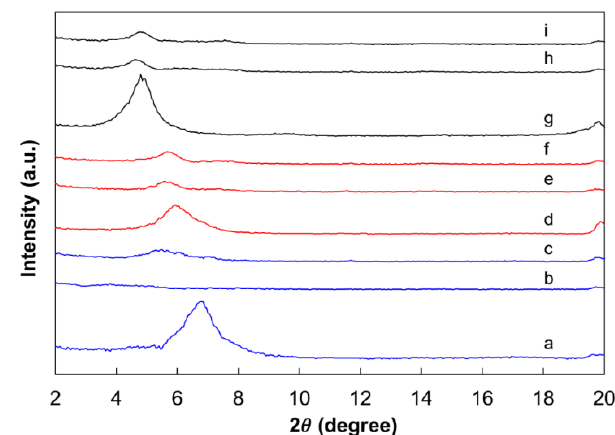
Figure 5. X-ray diffraction spectra of natural clays and hydrogel samples prepared in distilled or field water at 85 °C, with 0.6 wt % polymer, 0.5 wt % PEI, and 0.8 wt % clay (F4). a , sodium bentonite in